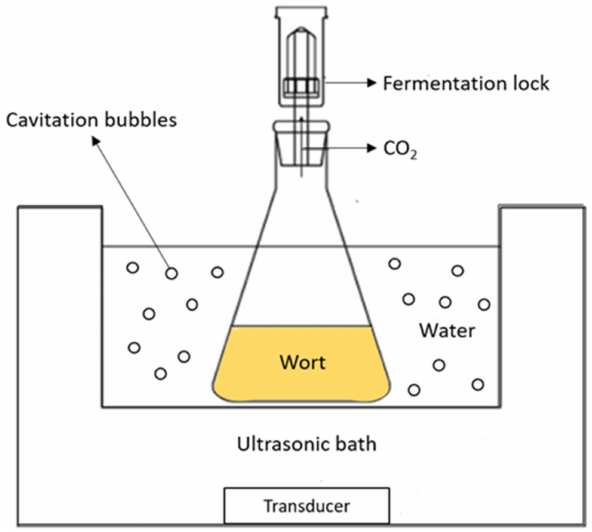
Figure 4. Representation of ultrasonic